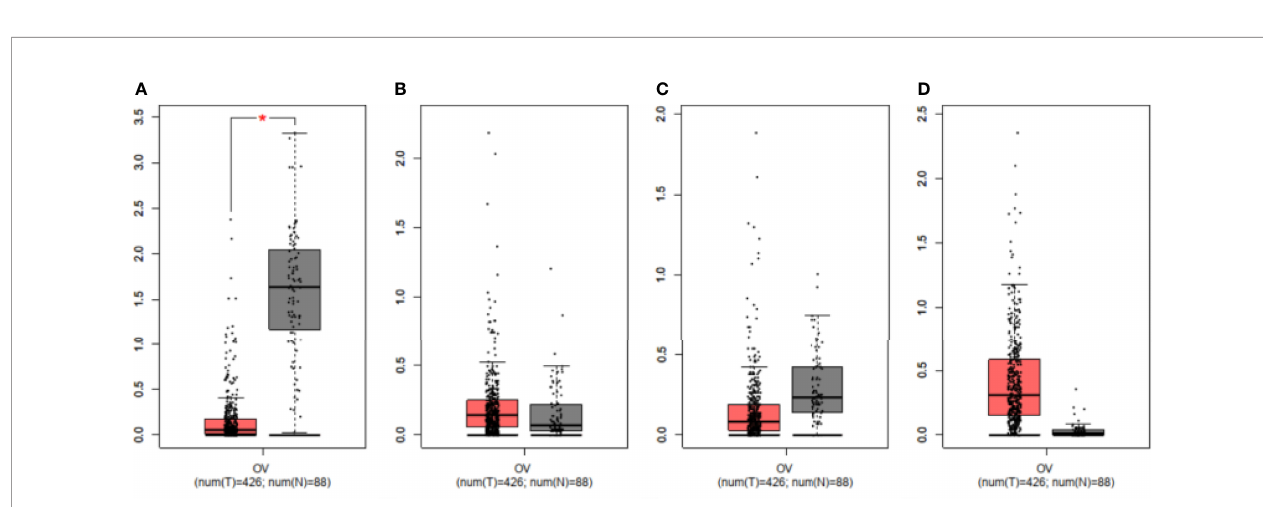
FIGURE 4 | Validation of mRNA expression levels of (A) FFAR1, (B) FFAR2, (C) FFAR3, (D) FFAR4 in OC tissues and normal ovary tissues using GEPIA. The box plots were based on 426 OC (showed in red)and 88 normal ovary samples(showed in grey). *P < 0.01 was considered statistically signi fi cant.